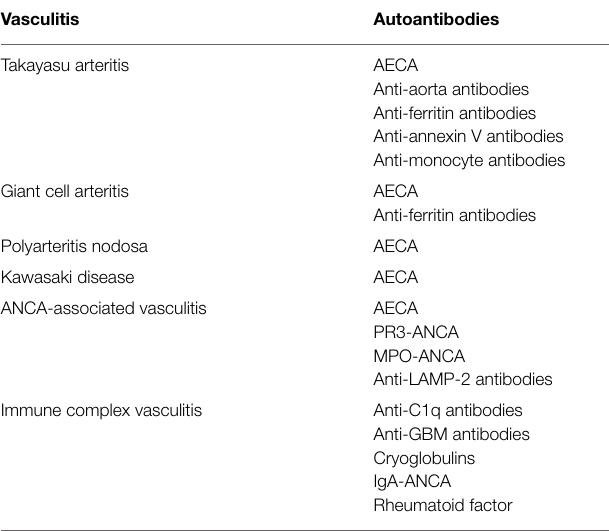
TABLE 1 | Autoantibodies in primary systemic vasculitides